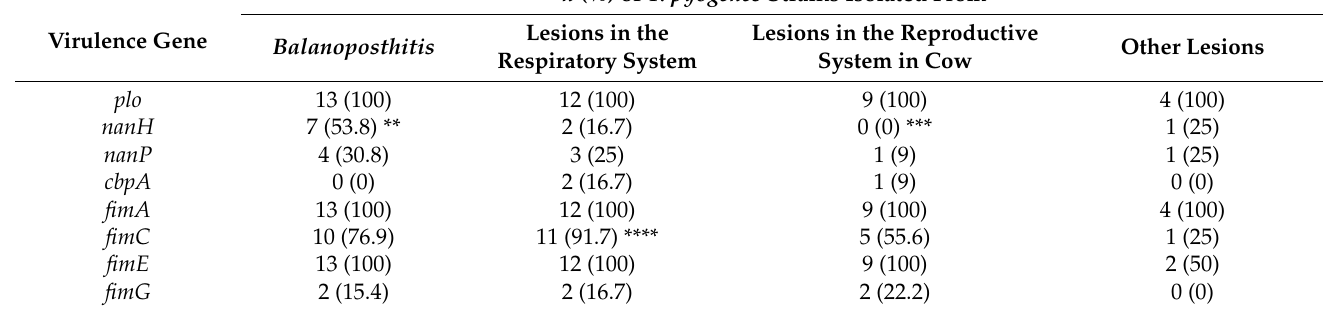
Table 3. The prevalence of virulence genes in T. pyogenes strains isolated from different types of infections in European bison ( n =